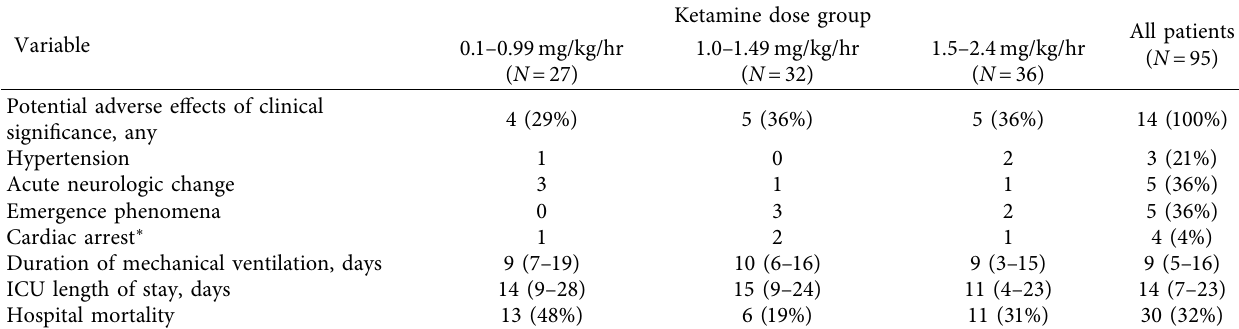
Table 2: Potential adverse efects of ketamine and patient outcomes (overall and stratifed by ketamine dose).